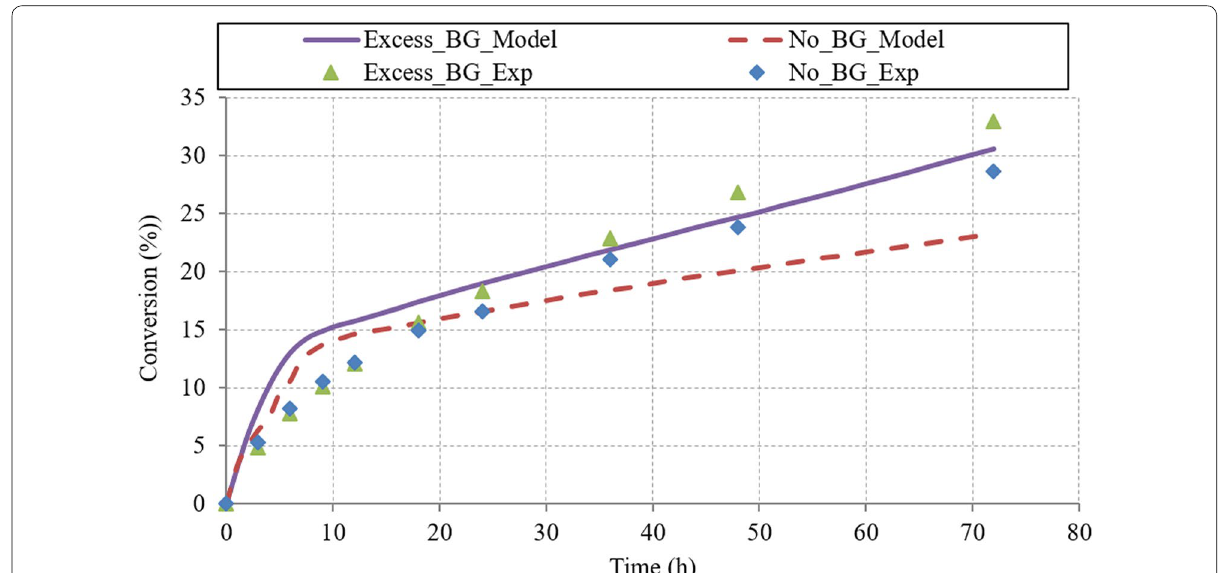
Fig. 13 Effect of β-glucosidase addition on cellulose hydrolysis by CBH II (25 g/L filter paper; CBH II: 10 mg/g